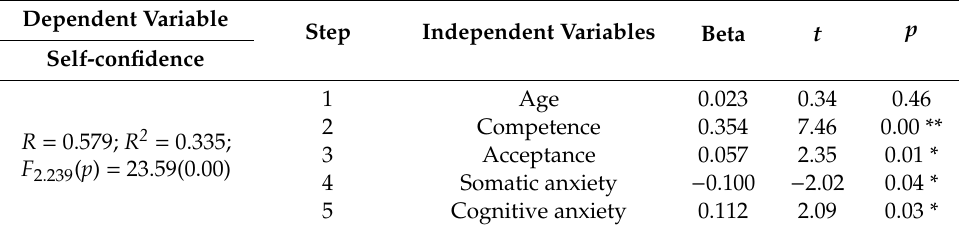
Table 6. Variable predictors of young players’ self-confidence.